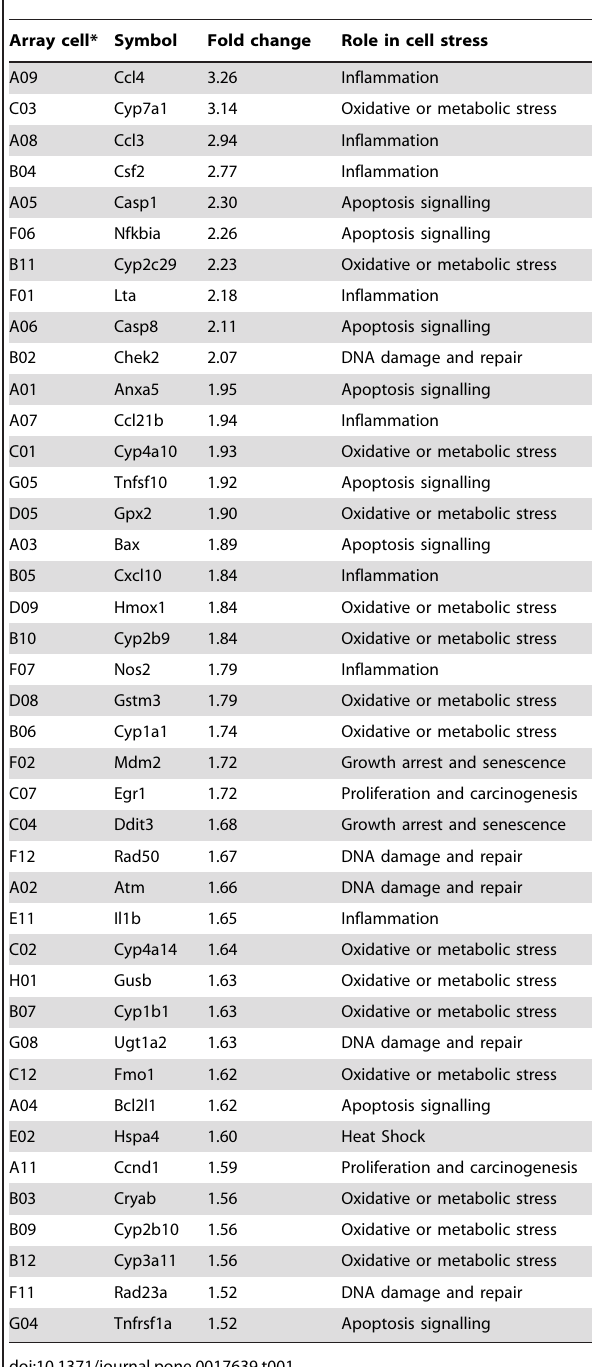
Table 1. Mouse SuperArray data showing greater than 1.5 fold cell stress RNA expression changes in the spinal cord of YFP-16 mice compared with wild-type controls (*array cell refers to the location on the 3D bar chart in Fig.